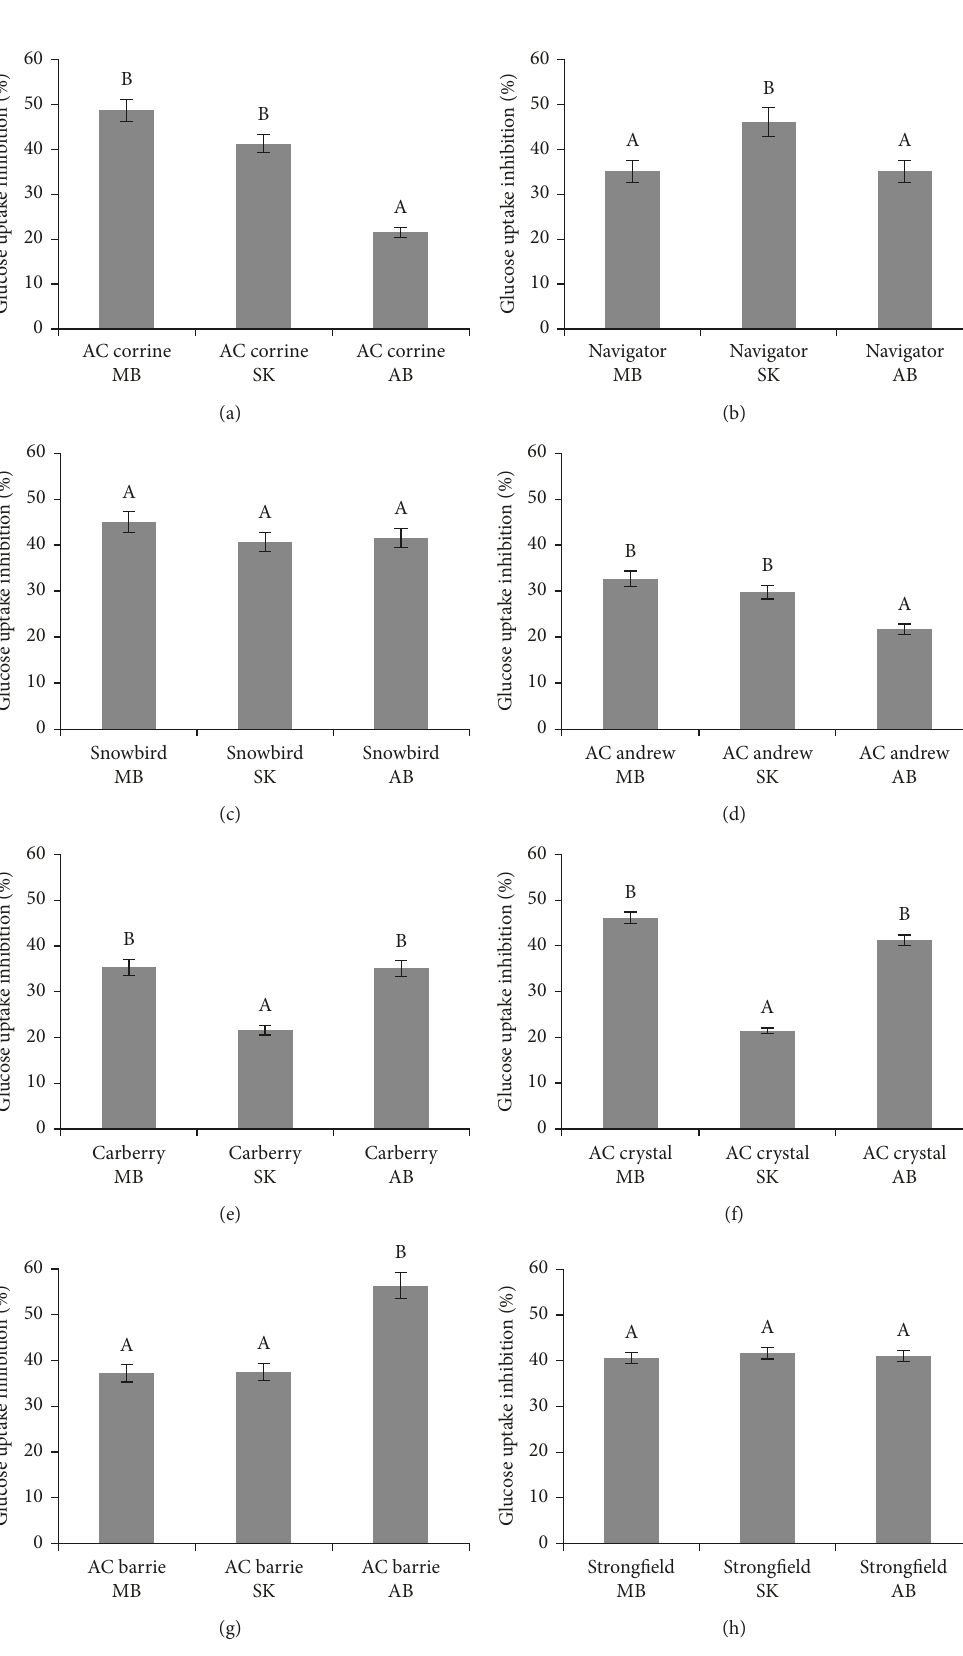
Figure 2: Relative inhibition of the uptake of [ 3 H] 2-deoxyglucose into CaCo-2 monolayers caused by extracts of free phenolic acids obtained from eight wheat genotypes (a–h) grown in MB, SK, and AB over 2011 crop year. A,B,C Different capital letter superscripts indicate significant differences ( P 0 . <